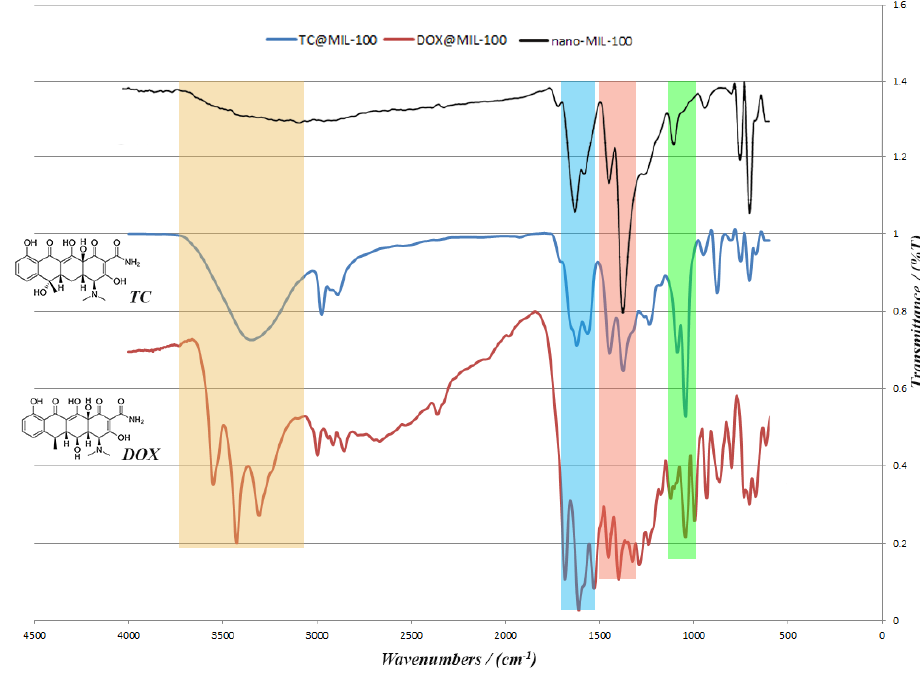
Figure 9. The FT-IR spectra for nano-MIL-100; TC@MIL-100 and DOX@MIL-100.